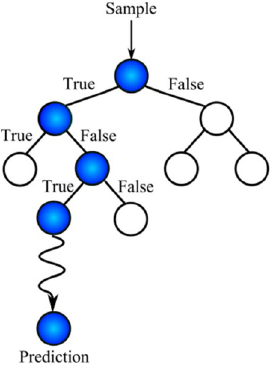
Figure 1. Demonstration of a typical decision trees.